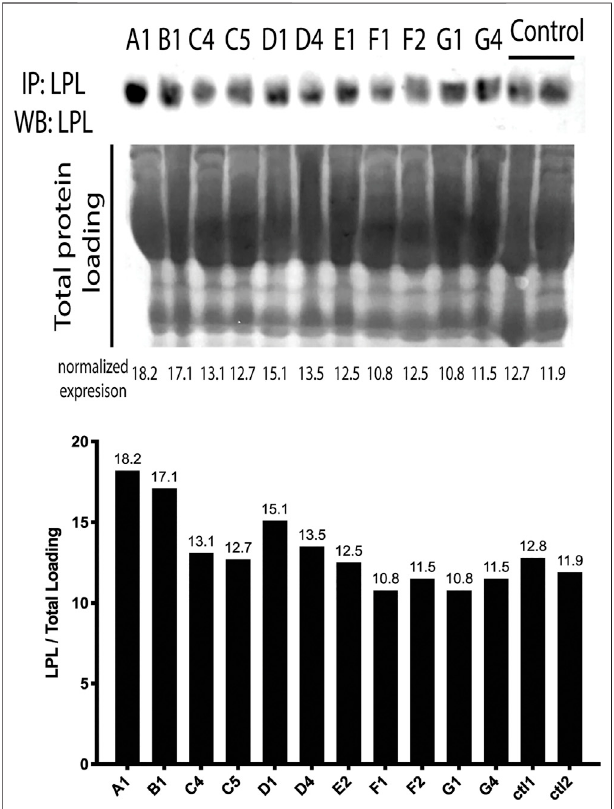
FIGURE 2 | LPL protein levels in the serum of affected individuals. The LPL densities were normalized to total protein loading. Both Ctl1 and Ctl2 are normal control samples. Individuals ‘ labels are as follows: A1:AA1, B1:BB1, C4:CC4, C5:CC5, D1:DD1, D4:DD4, E2: EE2, F1: FF1, F2: FF2, G1: GG1, G4: